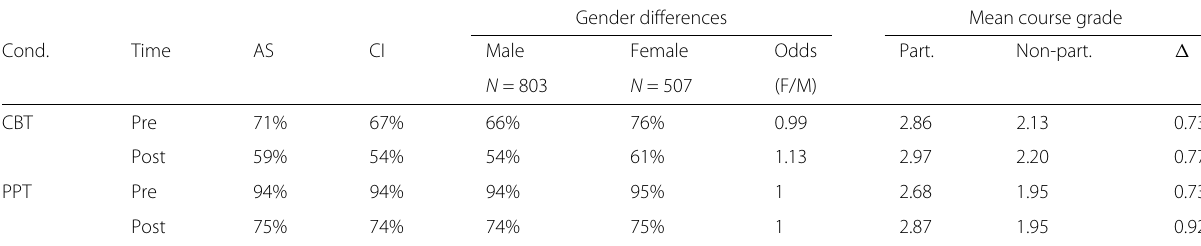
Table 4 Participation rates for pre and post CBT and PPT administered